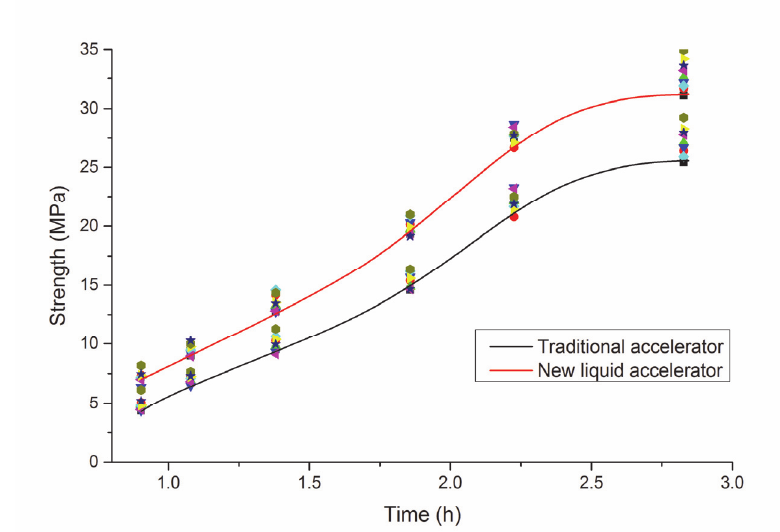
Figure 3: Strength-time regression curve of shotcrete added with accelerator.